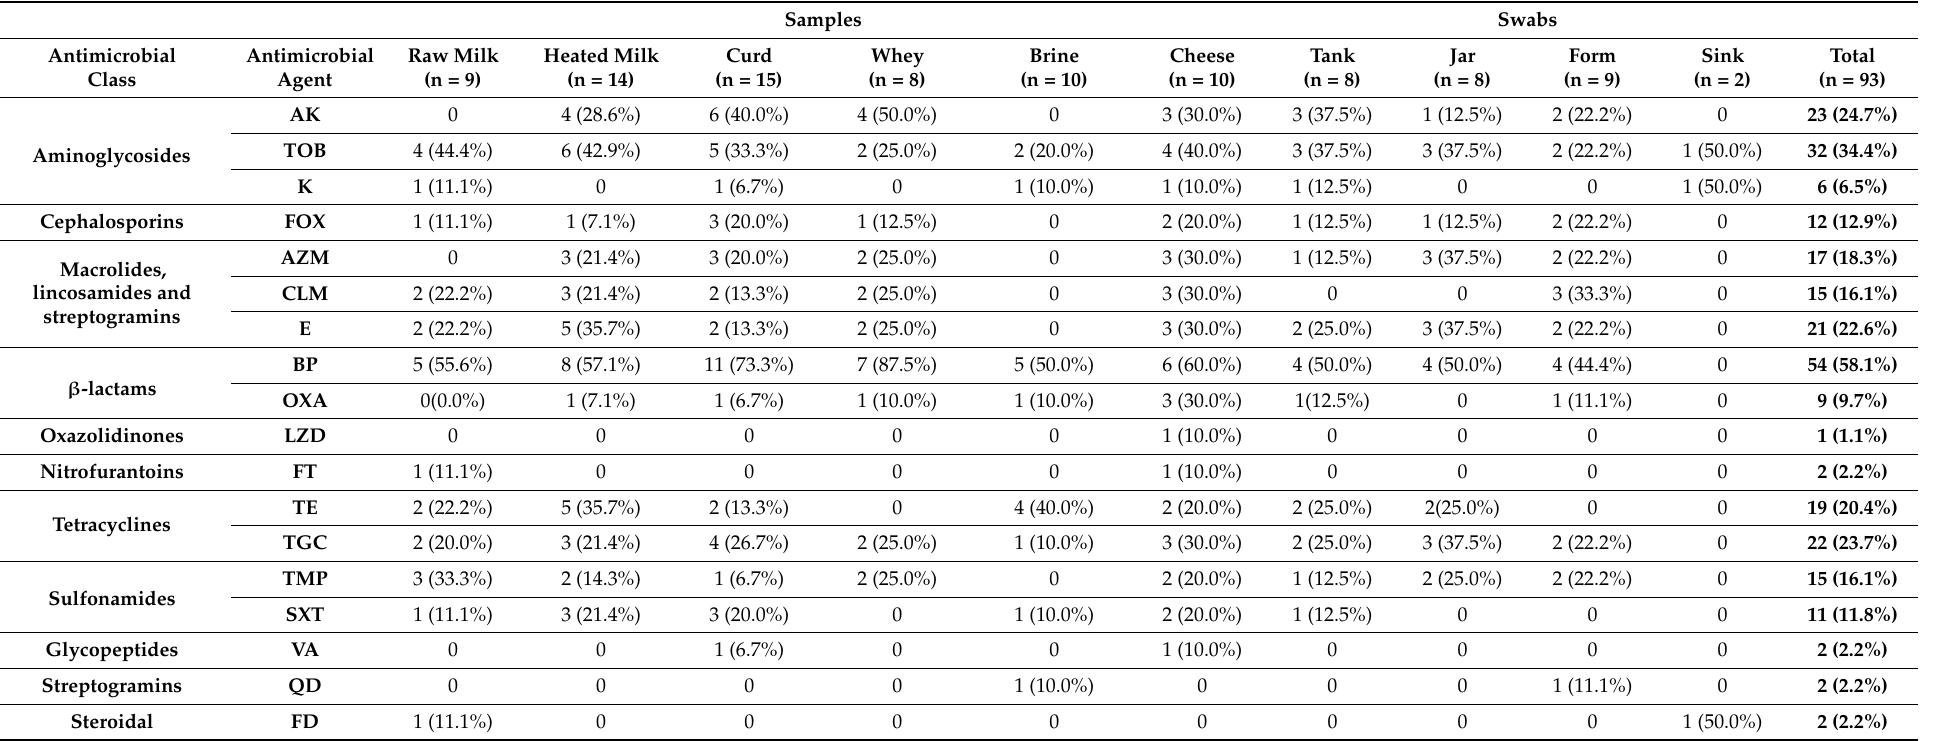
Table 2. Antimicrobial resistance profiles of S. aureus against tested antimicrobial